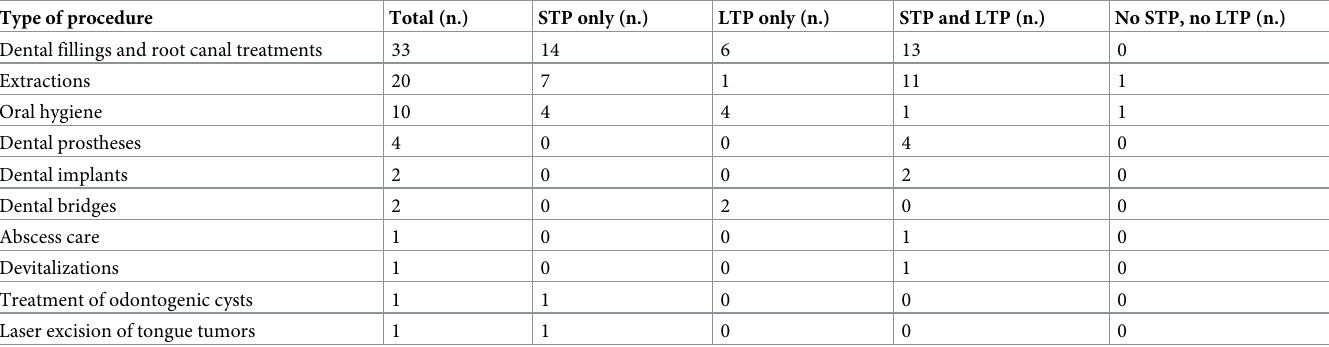
Table 4. Type of procedures and of prophylaxis undertaken (n = 20).